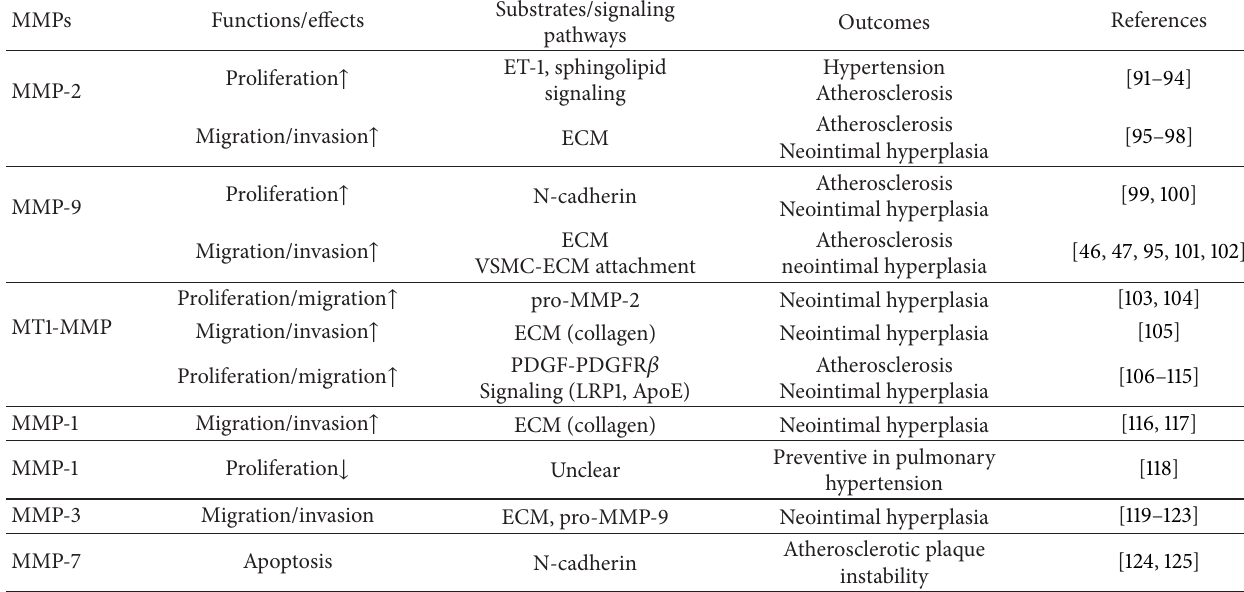
Table 3: MMPs and VSMC behaviors in vascular